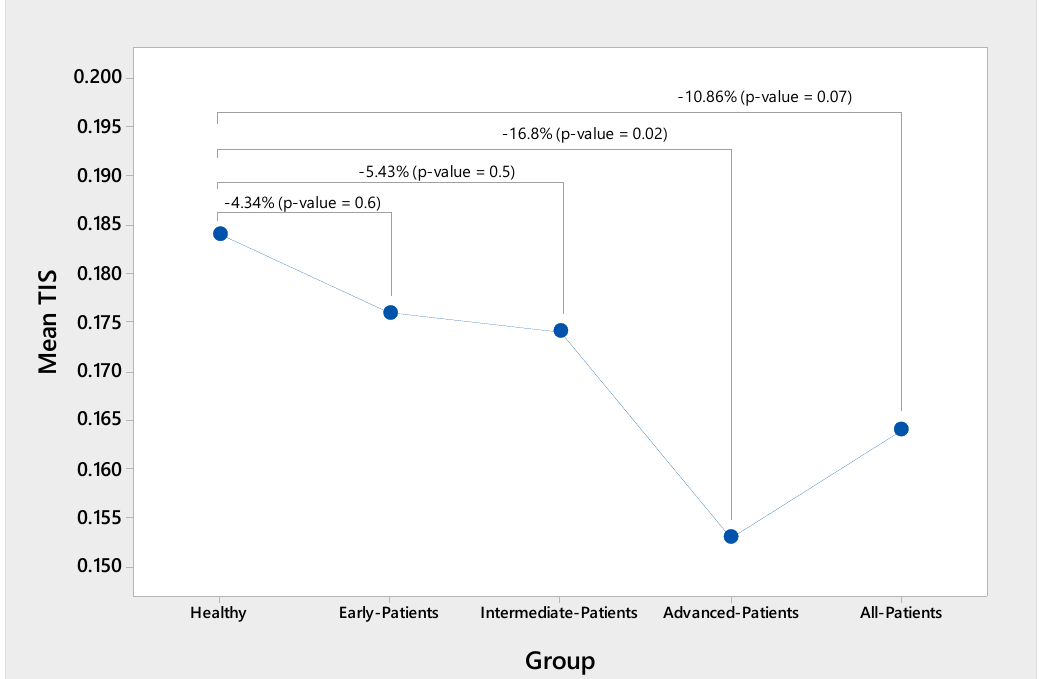
Figure 2. Linear mixed effect (LME) fixed effects coefficients of the Temporal Irregularity Score (TIS) (with age as covariate) across the five subjects groups. p -values (groups: Early, Intermediate, Advanced, and All patients) with respect to healthy subjects were: 0.6, 0.5, 0.02, 0.07. Number of participants: Healthy ( n = 22), Early ( n = 7), Intermediate ( n = 8), Advanced ( n = 4), All patients ( n = 19). Number of observations: Healthy ( n = 176), Early ( n = 93), Intermediate ( n = 90), Advanced ( n = 57), All patients ( n = 240).